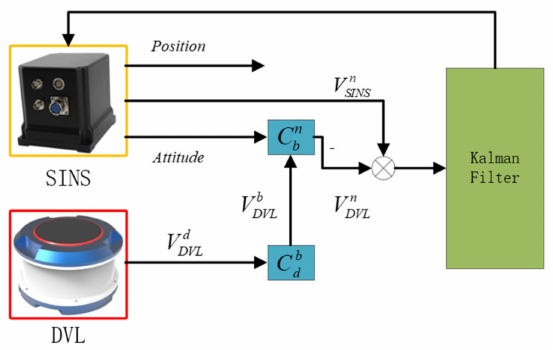
Figure 2. Schematic diagram of the principle of the integrated navigation